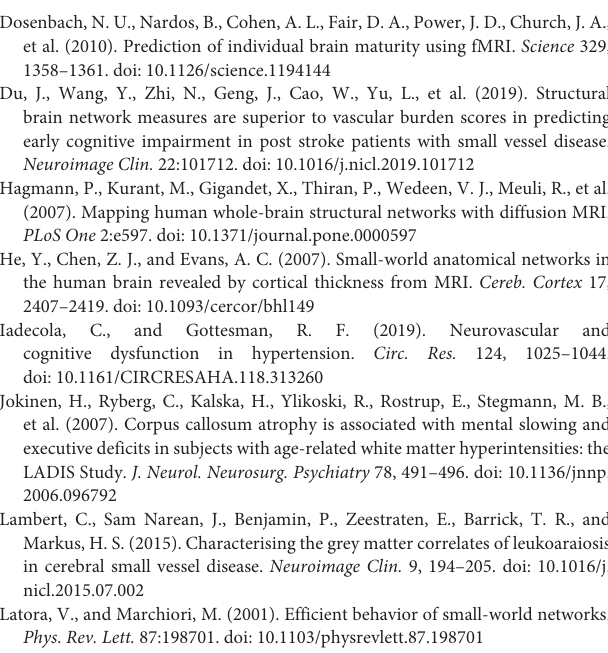
FIGURE S1 | Validation results with the “scrubbing” procedure for head motion correction in the preprocessing steps. To determine the extent to which our findings were robust to the motion correction strategy, we repeated the network centrality analyses using the scrubbed R-fMRI data and found that our main results identified in the primary analyses were not affected. Black asterisks (*) indicate a significant difference between the ILA and HC groups (permutation testing, P < 0.05). HC, healthy control; ILA, ischemic leukoaraiosis; R-fMRI, resting-state functional MRI. FIGURE S2 | Reproducibility of our principal findings using other parcellation schemes. We reconstructed the functional brain networks using the Dosenbach-160 atlases and found that our main results could be reproduced. Black asterisks (*) indicate a significant difference between the ILA and HC groups (permutation testing, P < 0.05). HC, healthy control; ILA, ischemic